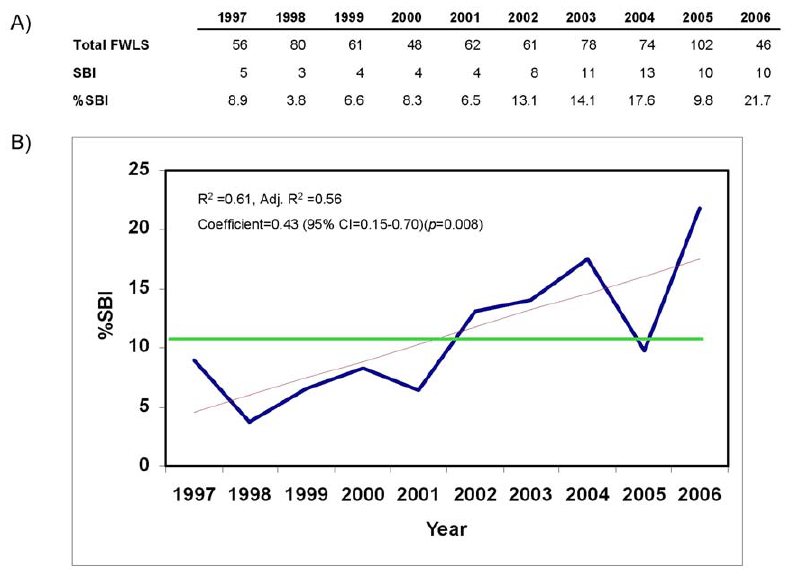
Figure 1. Analysis of Raw Data and Trends in SBIs among FWLS Infants, 1997–2006. A) Raw numbers of FWLS infants as well as SBIs and % SBI. B) Data in Figure 1a is graphed by %SBI on the y axis and year on the x axis (blue line). Also presented: overall mean %SBI (green line) and linear regression (red line). Statistical data on linear regression line is included.